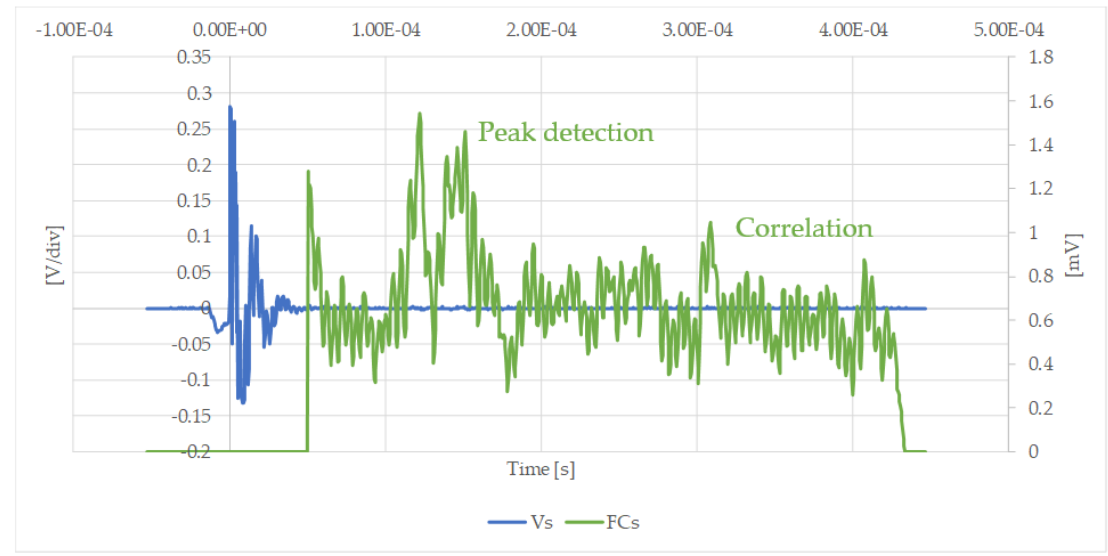
Figure 23. New sensor results: Experimental signal in the receiver, Vs [V], and filtered signal, FCs [mV] after using the correlation filter with a partial cement blockage in position B-3.